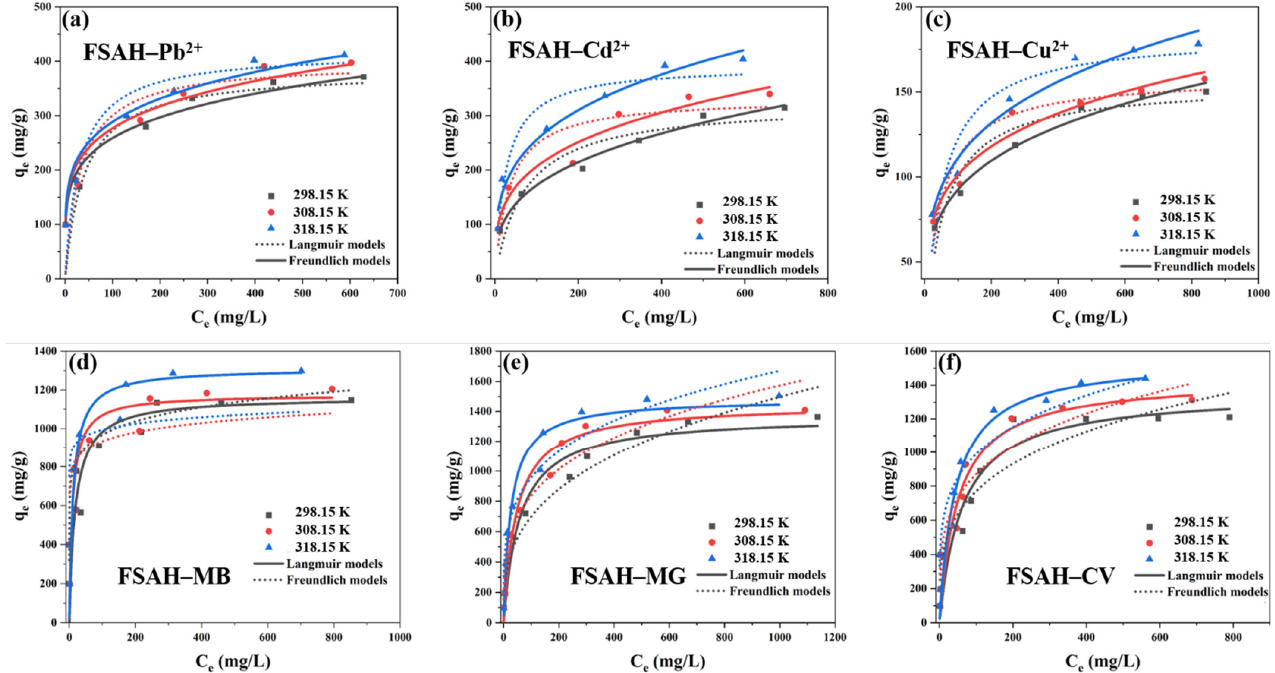
Figure 5. FSAH adsorption isotherm curves fitted by the Langmuir and Freundlich models to ad- sorb Pb 2+ ( a ), Cd 2+ ( b ), Cu 2+ ( c ), MB ( d ), MG ( e ), and CV ( f